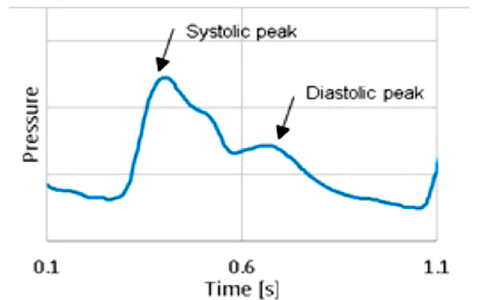
Figure 6. Pressure waveform during one heartbeat.